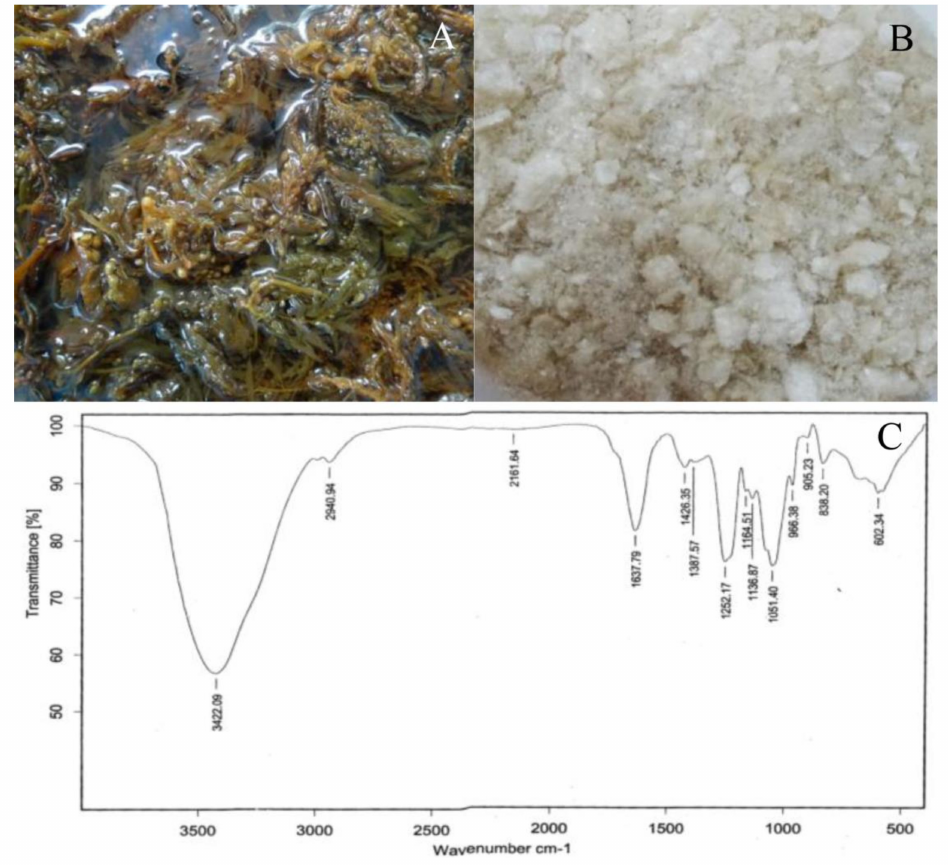
Figure 1. Fresh Sargassum polycystum C. Agardh ( A ), seaweed extract (SWE) of S. polycystum ( B ), and FTIR spectrum of SWE ( C